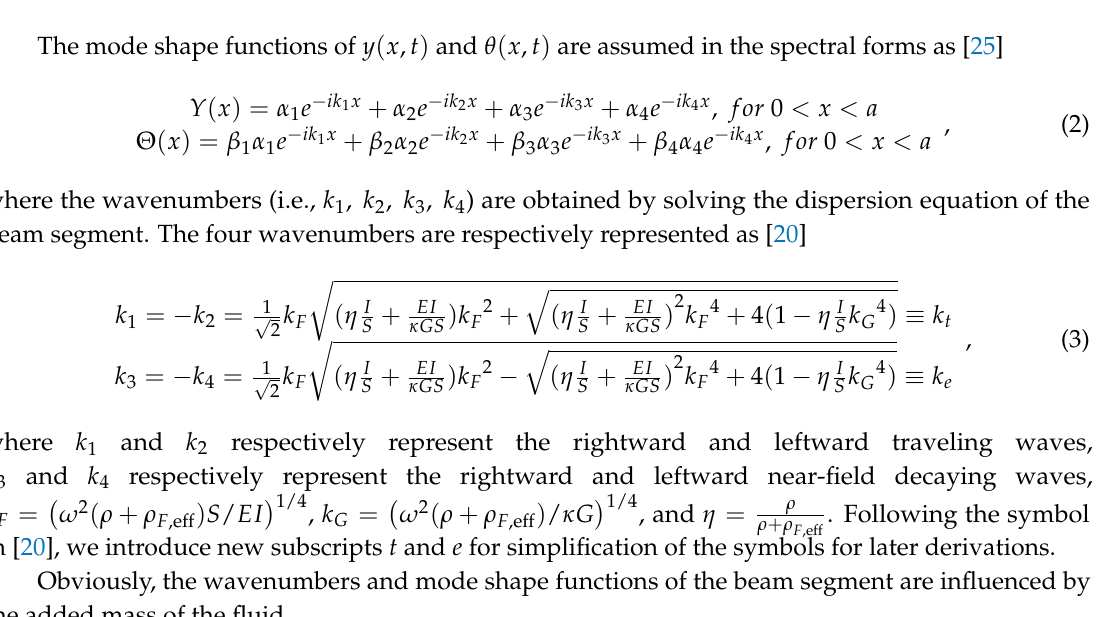
Figure 1. Schematic representation of: ( a ) a unit cell of the PC beam immersed in water; ( b ) the force equilibrium of a submerged beam segment.